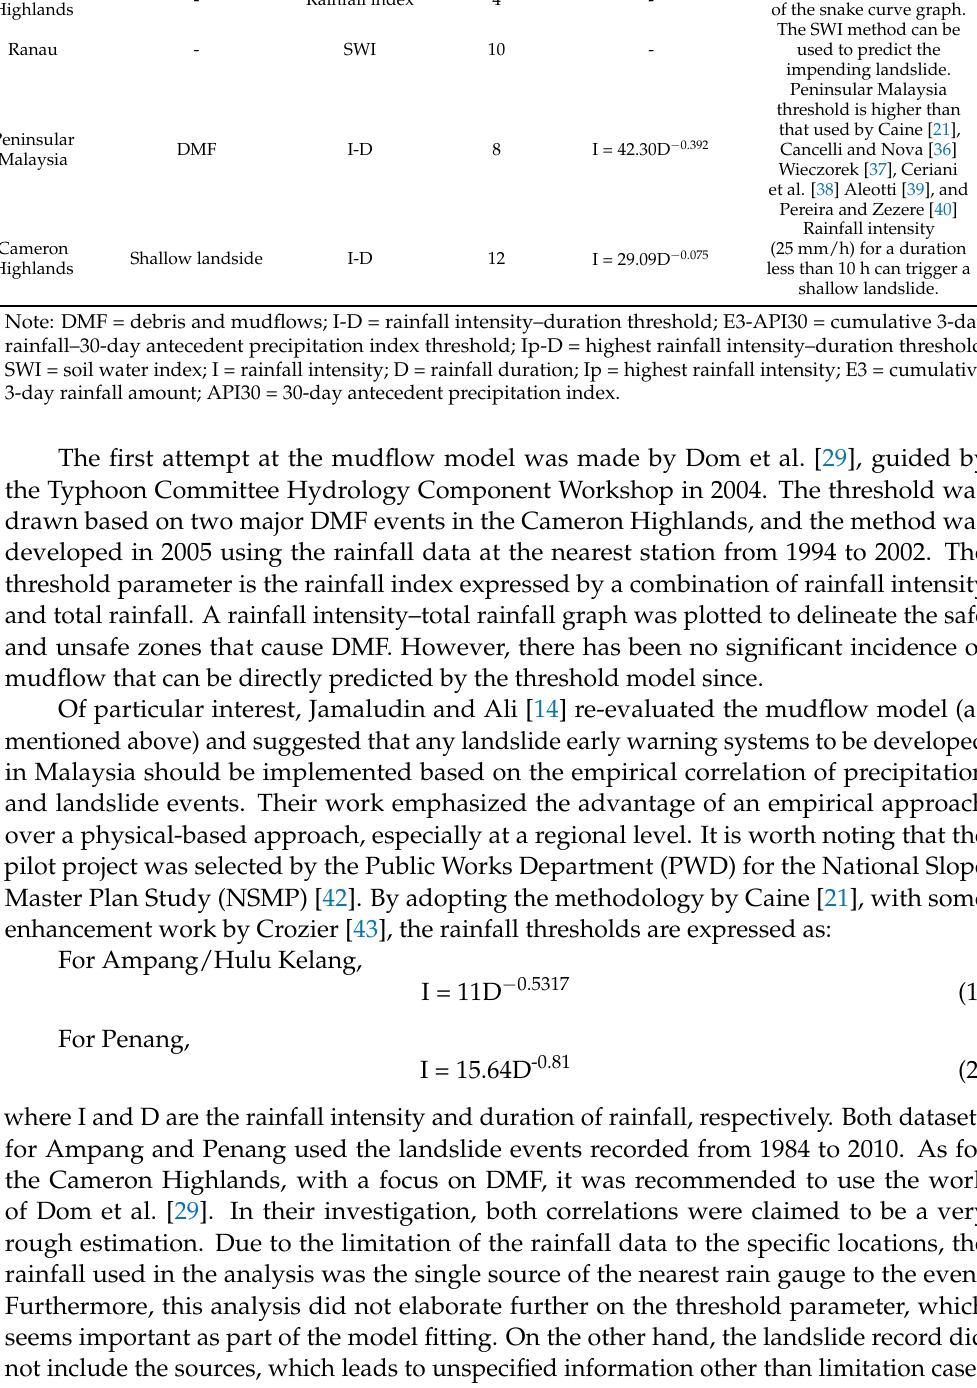
Improved the critical line of the snake curve